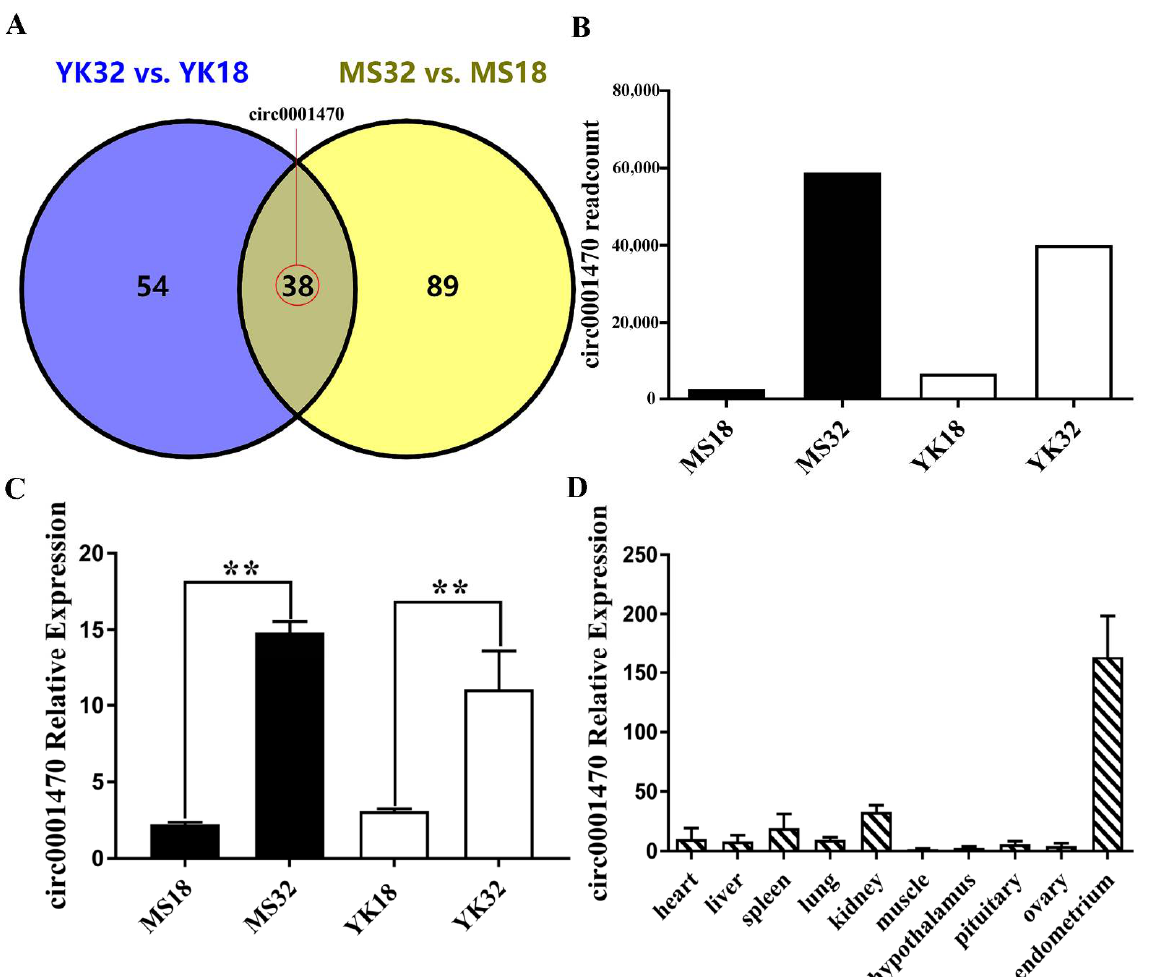
Figure 1. Circ0001470 expression profiling was screened and identified in endometrial tissue. ( A ) Venn diagram analysis of the number of differentially expressed circRNAs during the different periods of the Meishan and Yorkshire pigs. ( B ) RNA-seq sequencing data revealed a readcount of circ0001470 in the endometrium of the two breeds at 18 and 32 days of gestation. ( C ) Circ0001470 expression patterns in the endometrium of Meishan and Yorkshire pigs at 18 and 32 days of gestation. ( D ) Circ0001470 expression levels in different tissues of Yorkshire pigs at 32 days of gestation were detected by qRT-PCR. The data are represented as mean ± standard deviation. All data are representatives of three independent experiments. ** represents p < 0.01.